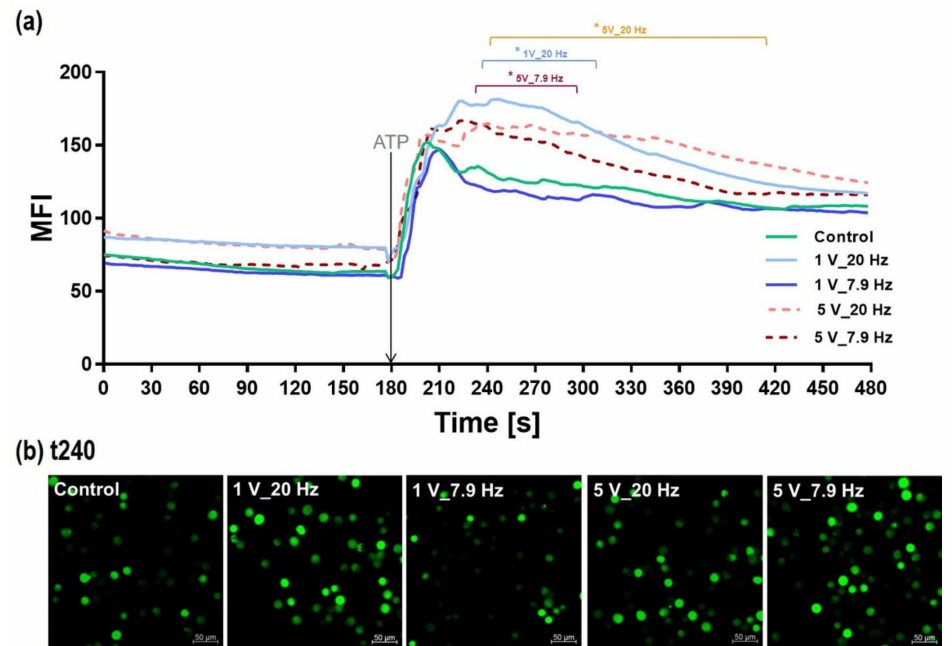
Figure 9. The intracellular calcium ion (Ca 2+ ) signal of fluo-3-loaded MG-63s after 10 min electrical stimulation. ( a ) The time course of the Ca 2+ signal (0–480 s) was immediately started after the 10 min AC stimulation (0 s). The adenosine triphosphate (ATP) addition was at time point 180 s. Note that electrical stimulation with 20 Hz (1 and 5 V) and 5 V_7.9 Hz pre-activates the cells resulting in a significantly increased mobilization of calcium ions after additional ATP. (Confocal microscope LSM780, Carl Zeiss; 6 independent experiments, defined areas of 10 cells per time point; polygon line as mean; multiple t -test, * p < 0.05 compared to Control). ( b ) Adequate fluorescence images of intracellular Ca 2+ levels after ATP in electrically pre-stimulated cells (time point: 240 s). (LSM780, scale bars = 50 µ m, 40 × water